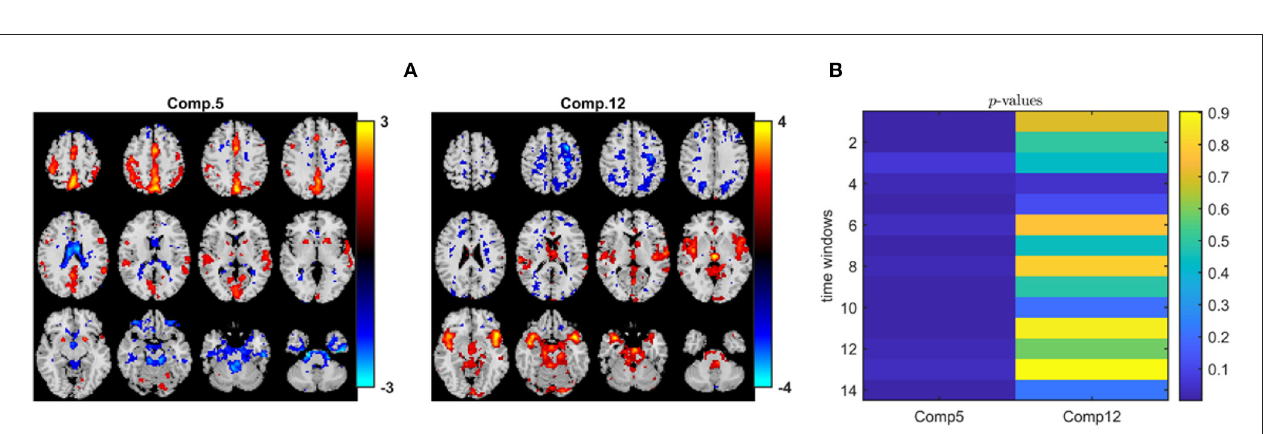
FIGURE 11 | IVA analysis of task fMRI data. (A) Spatial components, i.e., rows of S k . Here, we only plot two of the rows of S 1 corresponding to the first time window. Spatial maps are plotted using the patterns from the voxels mode as z-maps and thresholding at | z | ≥ 1.5 such that red voxels indicate an increase in controls over patients, and blue voxels indicate an increase in patients over controls. (B) p -values for the two components in each time window. While component 5 is statistically significant in all but one time window (i.e., time window 3), component 12 is not in any of the time windows.